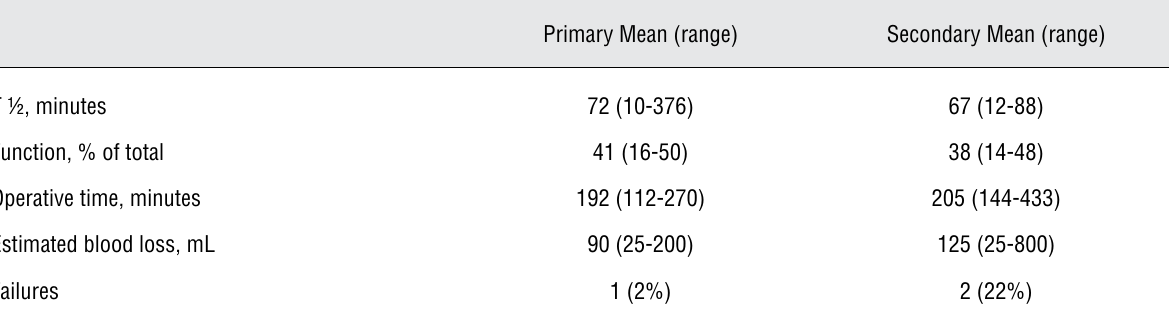
Table 3 - Primary vs. secondary